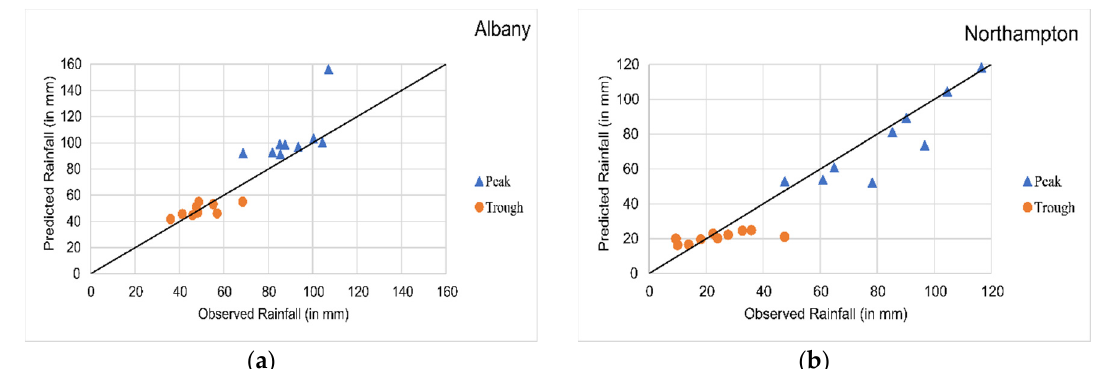
Figure 8. Peak and trough detection using ARIMAX model for ( a ) Albany and ( b ) Northampton. Table 9. Pearson correlation (r) between combined climate indices and Western Australian